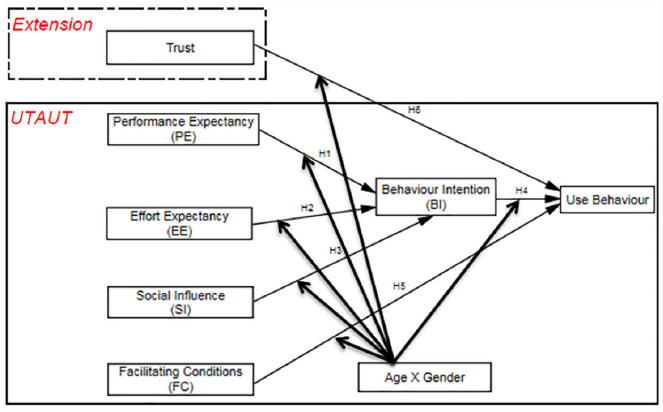
Fig. 1. The proposed method